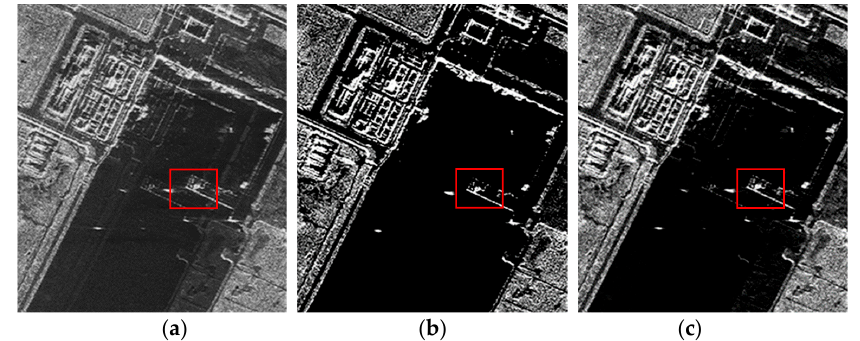
Figure 6. Image reconstructed via different algorithms with single-transmit three-receive SAR data. ( a ) Matched filtering. ( b ) Raw data-based sparse imaging method. ( c ) Complex image-based sparse imaging method. Table 3. Target-to-background ratio (TBR) of target area via different algorithms with multichannel data.